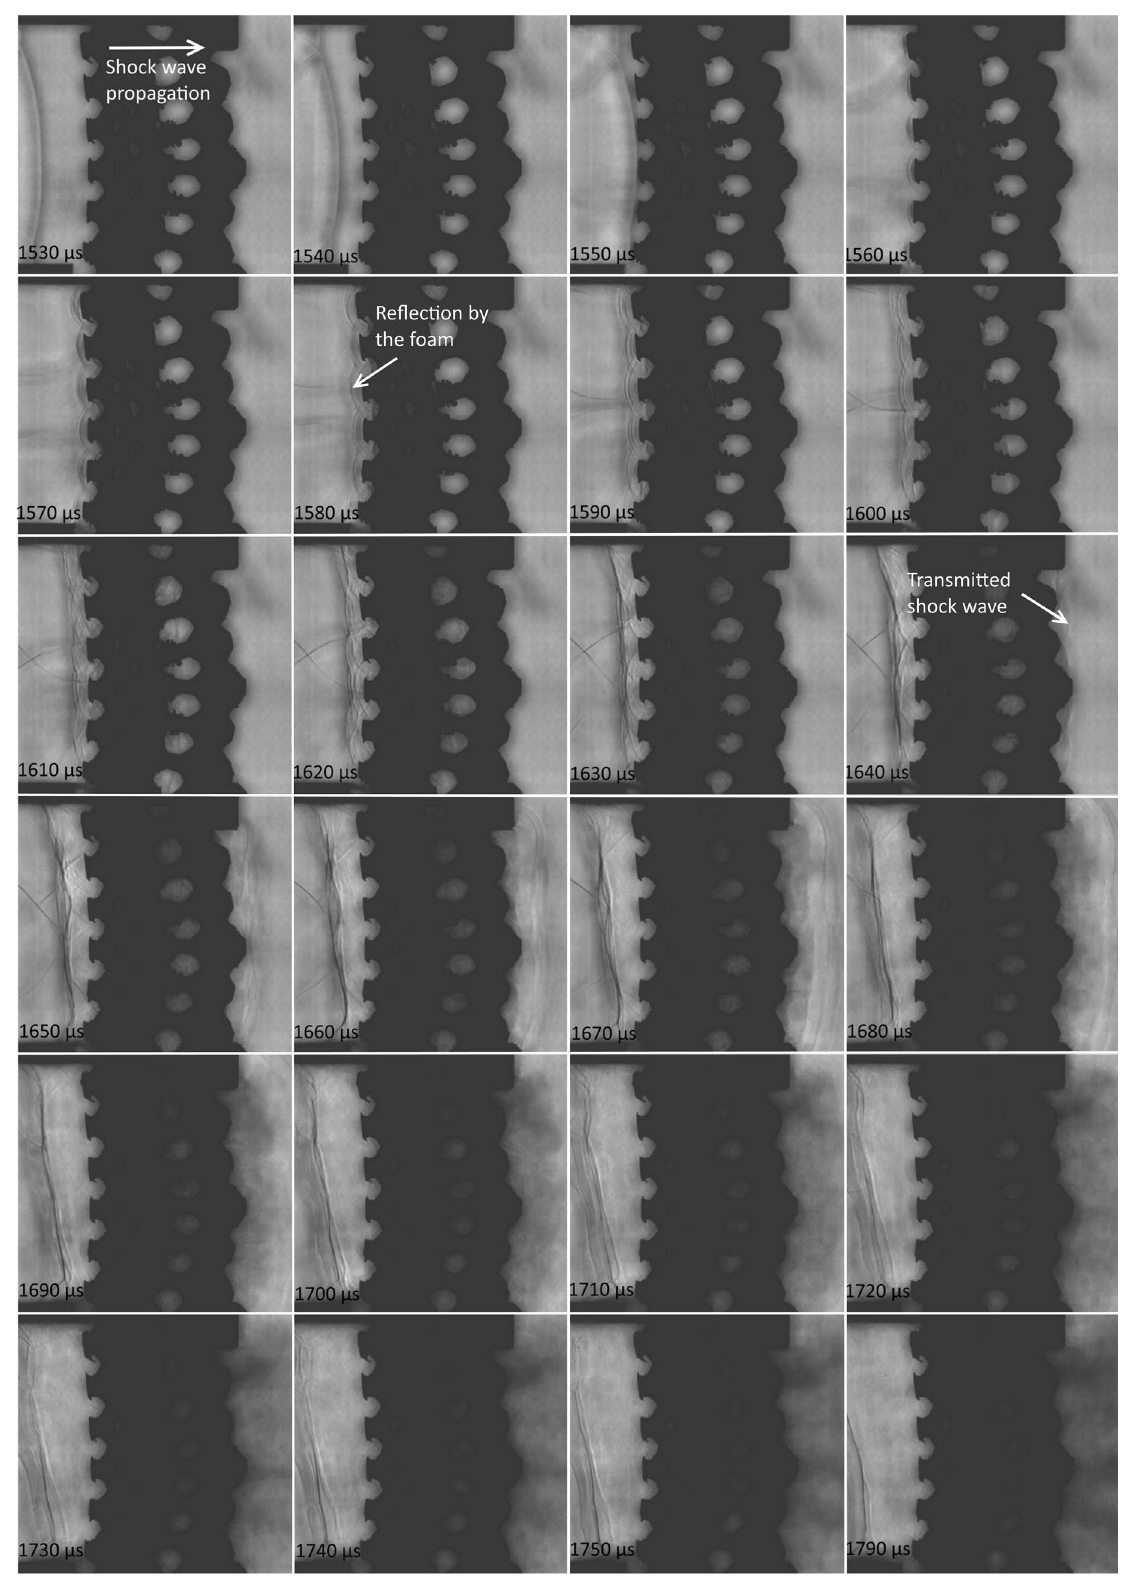
Fig. 9 Photographs resulting from fast video recording, showing the shock wave propagation through a slice of cast metallic